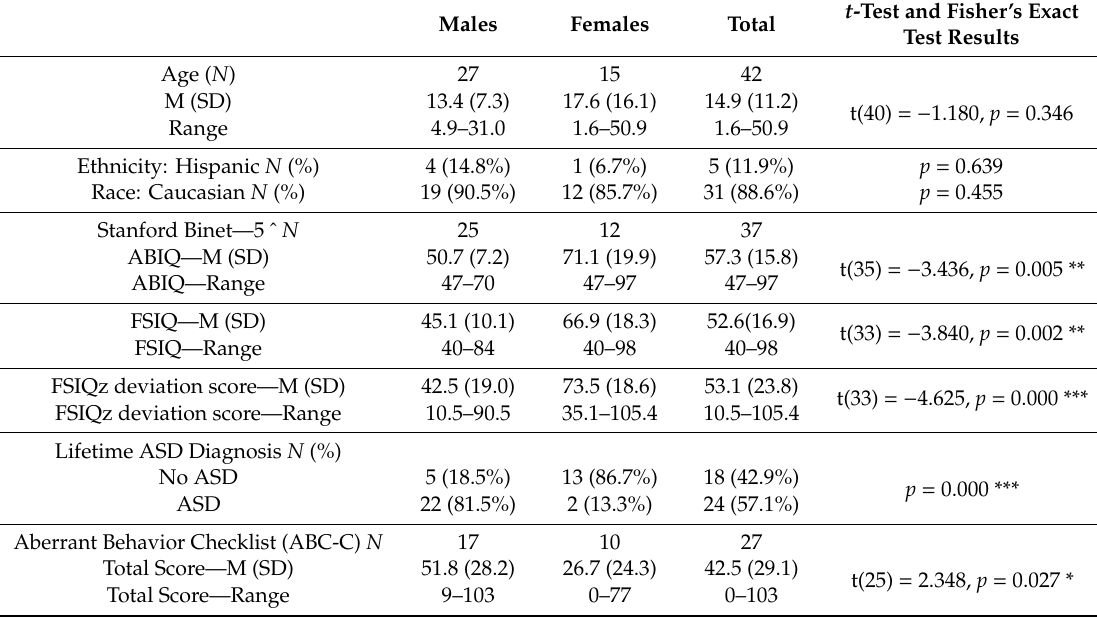
Table 2. Description of participants at time